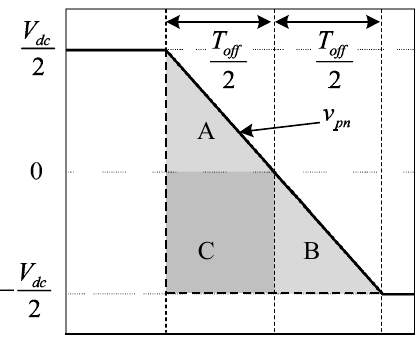
Figure 9. Detail of the dashed box in Figure 5c.